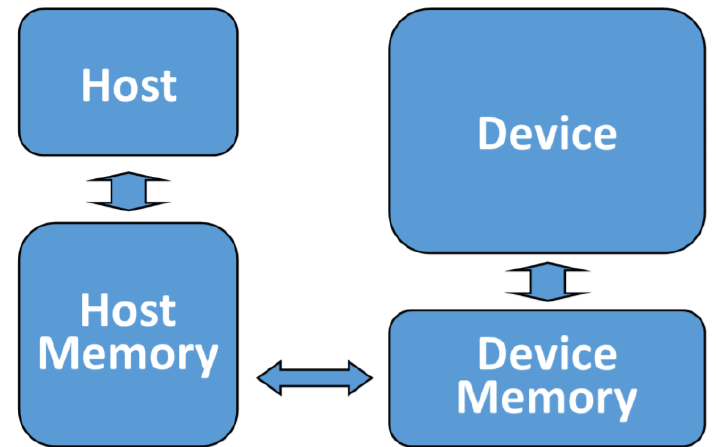
Fig. 1. OpenACC’s Abstract Accelerator Model